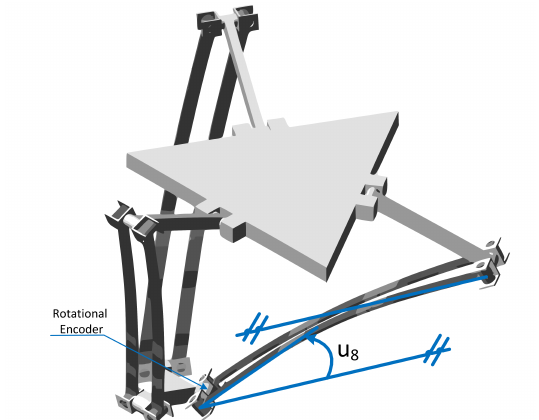
Figure 6. Rotational encoder position and the measured angle representation.